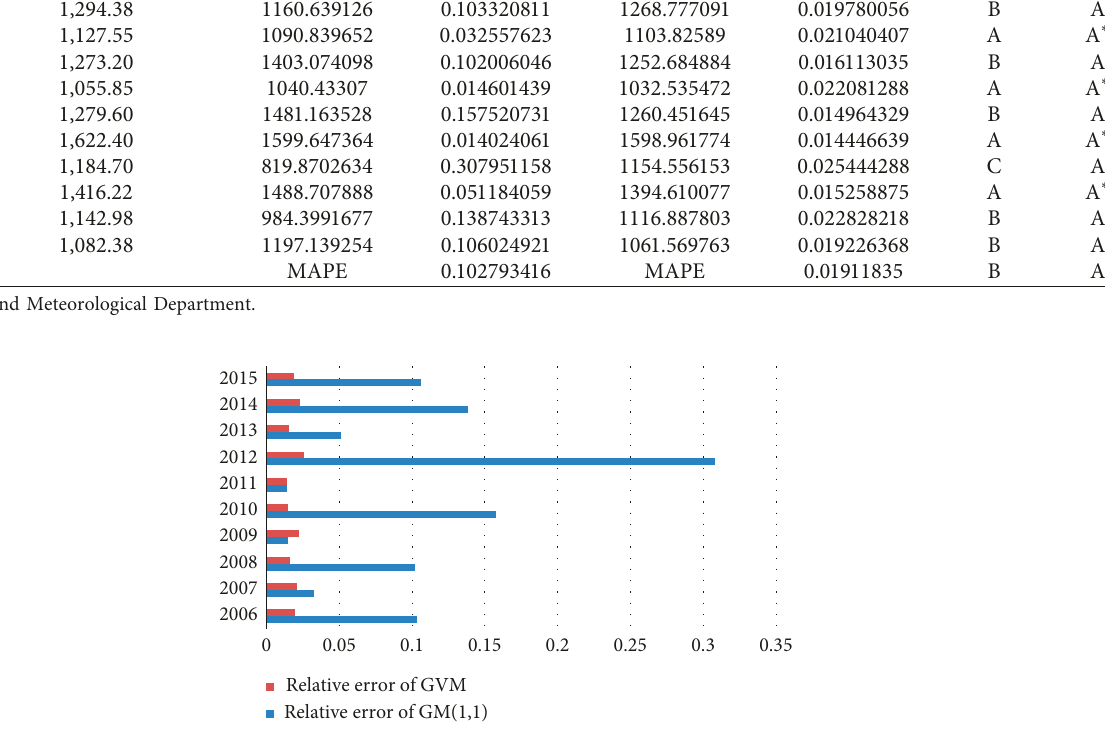
Figure 2: The comparison of MAPE of GM(1,1) (%) with MAPE of GVM (%). Table 3: The comparison of water in dam and relative errors of the two models from actual data